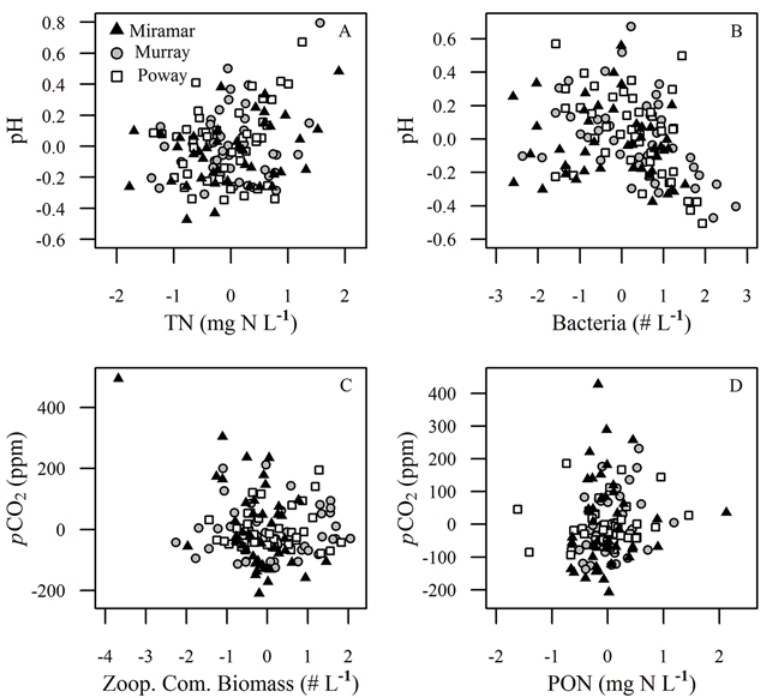
Fig 3. Partial regression plots of the significant drivers of pH and pCO 2 across all reservoirs. Drivers were identified by the model averaging procedure pH versus (A) total nitrogen (mg N L -1 ) and (B) bacteria abundance (# L -1 ), and pCO 2 versus (C) zooplankton community biomass (mg L -1 ) and (D) particulate organic nitrogen (mg N L -1 ). Symbols indicate the reservoir as shown in the legend.